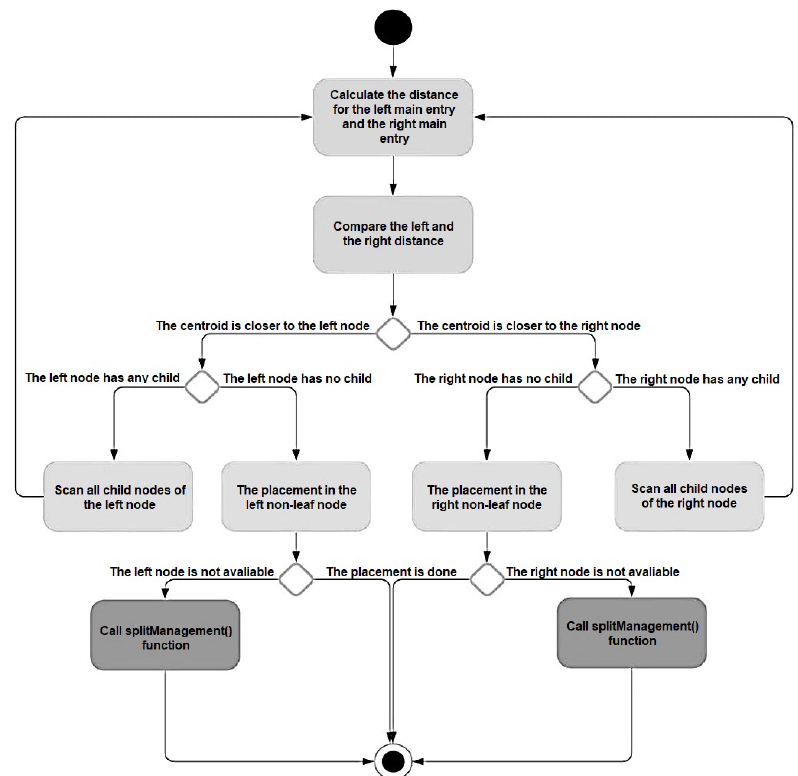
Figure 3. Locating the new centroid in an SC-F Tree for two clusters in each